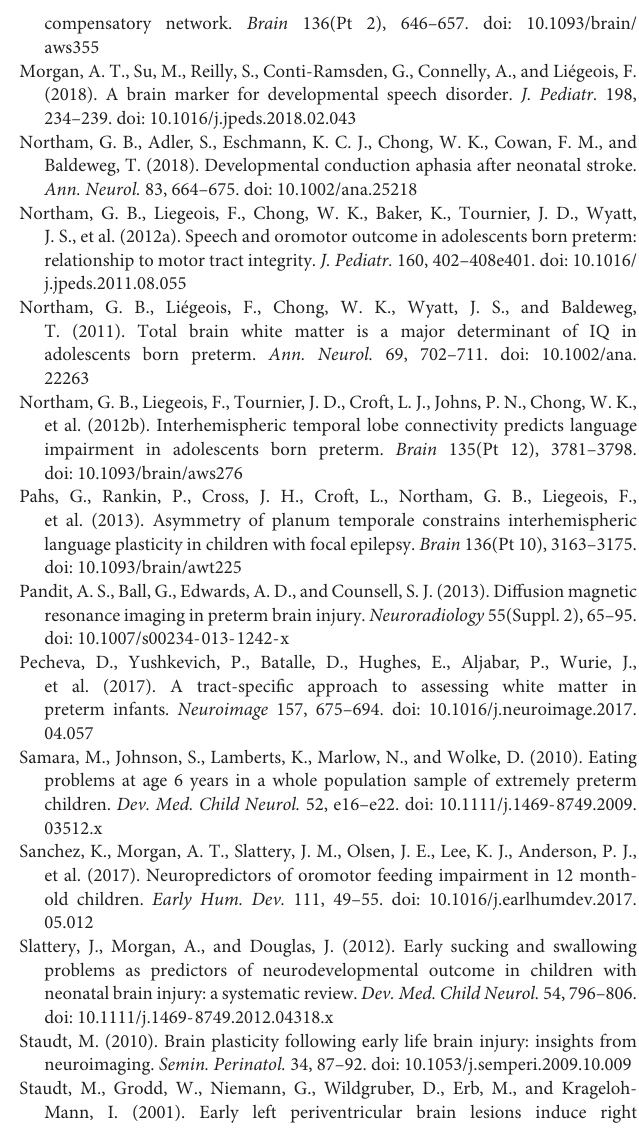
TABLE S1 | Clinical and neuropsychological characteristics of focal oromotor impairment